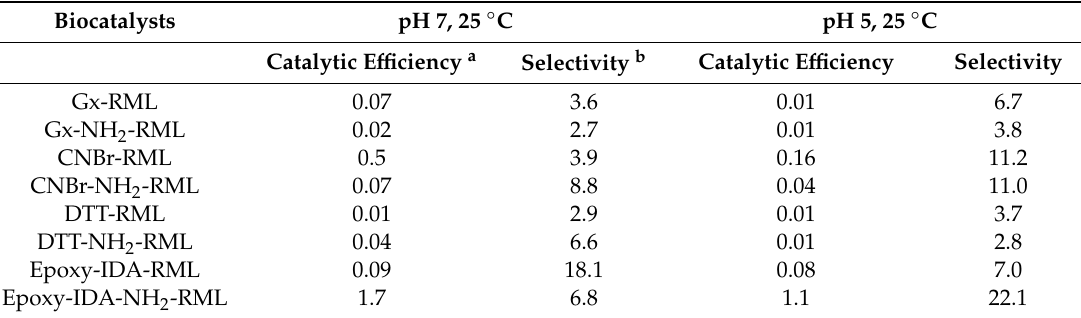
Table 2. Selective hydrolysis of fish oil by using the immobilized preparations. Biocatalysts